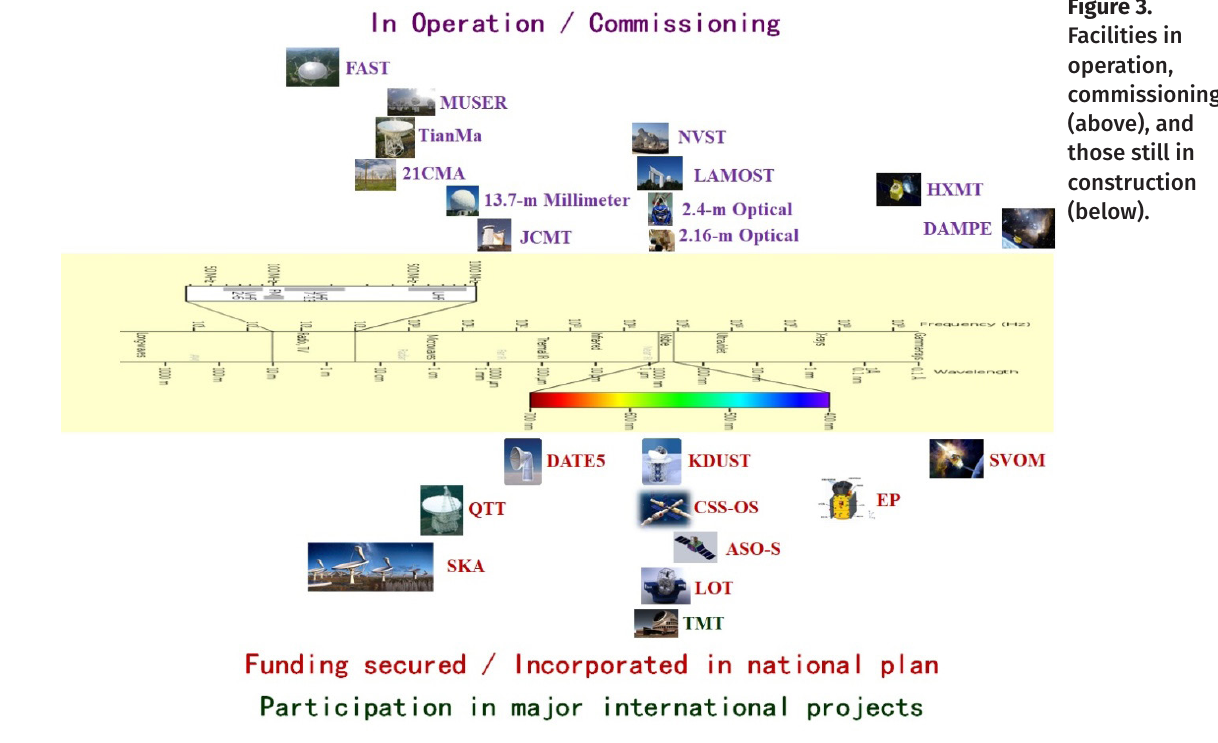
Figure 3. Facilities in operation, commissioning (above), and those still in construction